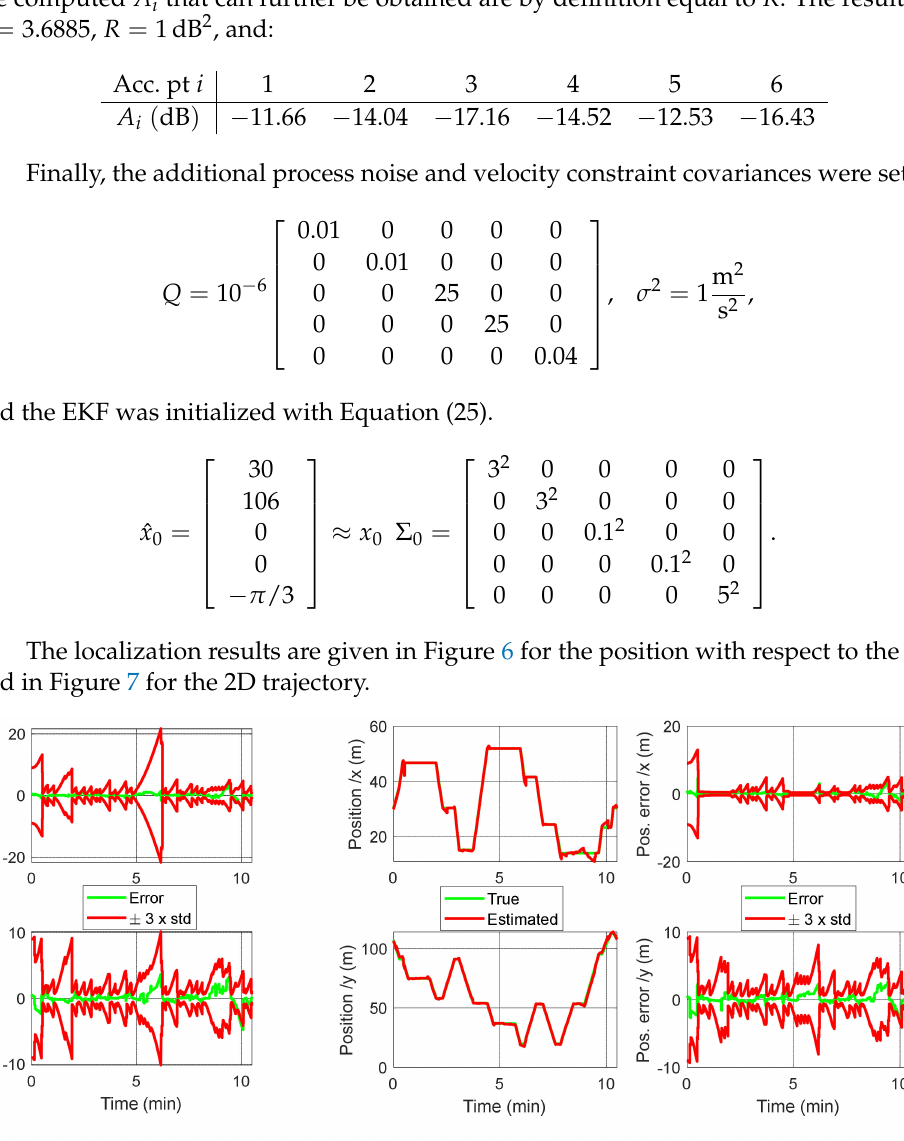
(cid:112) Σ ( 1,1 ) k